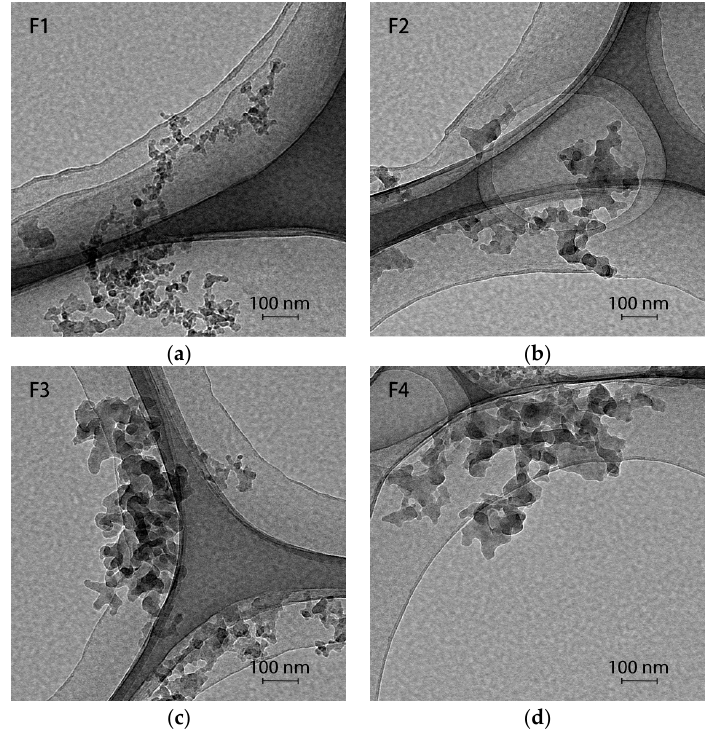
Figure 2. Aggregation morphology of nascent soot particles under different conditions: ( a ) pure ethylene; ( b ) 1-pentanol/ethylene; ( c ) 3-methyl-1-butanol/ethylene; ( d ) 2-methyl-1-butanol/ethylene.